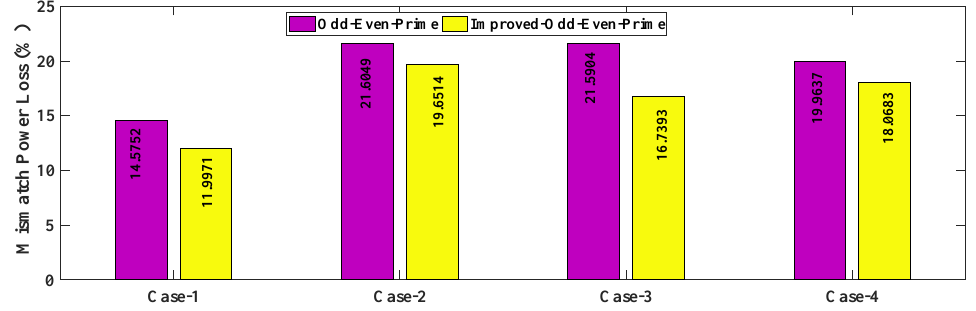
Figure 12. Mismatch power los s for 9 × 9 PV array.